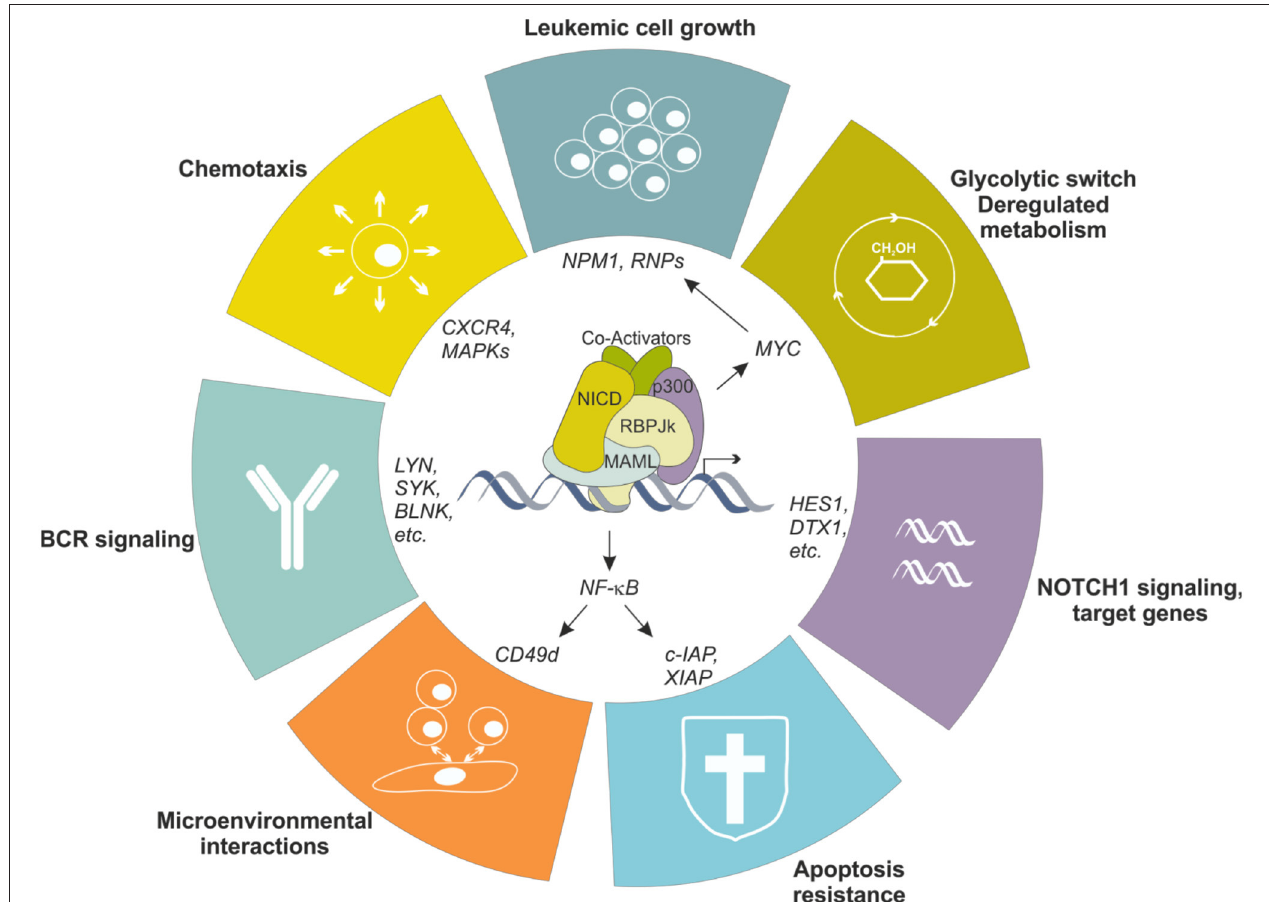
FIGURE 4 | NOTCH1 transcriptional effects in CLL cells. NOTCH1 signaling is aberrantly activated in CLL cells, resulting in transcriptional regulation of several genes, in turn impacting different biological aspects of the neoplastic cells. Increased NOTCH1 activity contributes to leukemic cell growth, protection from apoptosis, metabolic switching toward a glycolytic metabolism, increased migration in response to specific chemokines and facilitates interactions with microenvironment. Moreover, it upregulates several genes encoding proteins insisting on the BCR signaling pathway, the driving force for CLL cells.